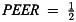
Contrast enhanced CT study.(a) Gadolinium in four spots and one strip (display window [0, 0.04]), and (b) the mono-energy image in the fourth energy channel with additional Gadolinium features (display window [0, 0.23] in linear attenuation coefficient) and the white circle indicates the spectral FOV in the case of PEER = 12.